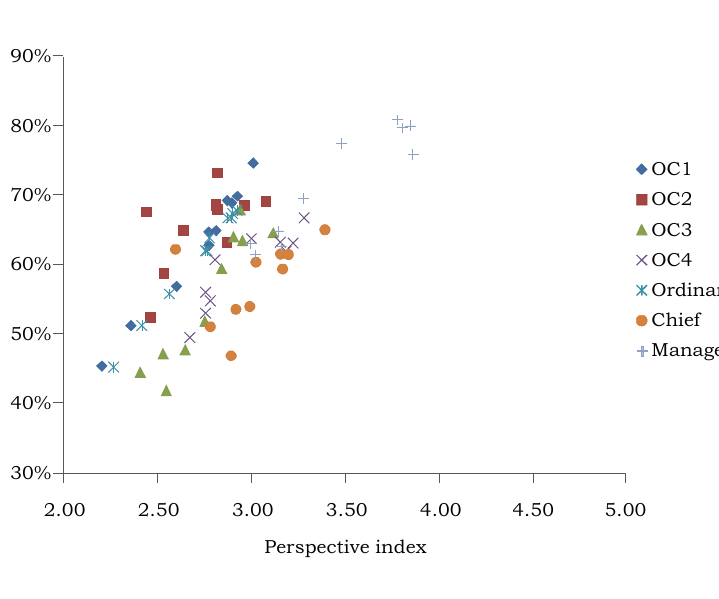
Figure 2. Perspective index by occupational and rank categories and annual transitions in job satisfaction